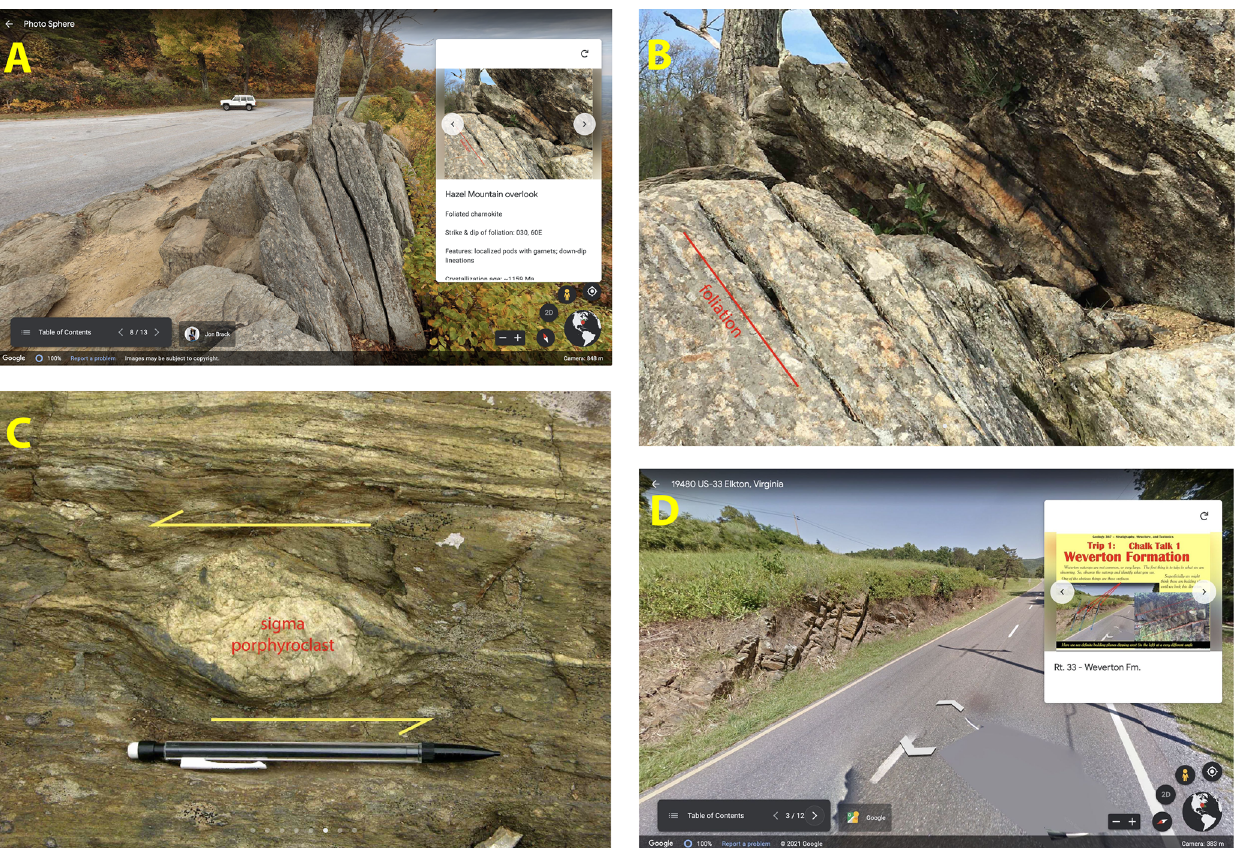
Figure 4. Screen images from web-based © Google Earth virtual field trips from the Mid Atlantic Appalachian Orogen Traverse project; (a) a Street View image of the Hazel Mtn. Overlook site from FT2, positioned to look along-strike of foliation; (b) an annotated photo of the same outcrop as (a) , highlighting the foliation; (c) an annotated photo of a complex sigma porphyroclast from the Garth Run site of FT2; (d) a Street View image of the first field trip site of FT1 on Rt. 33 in western